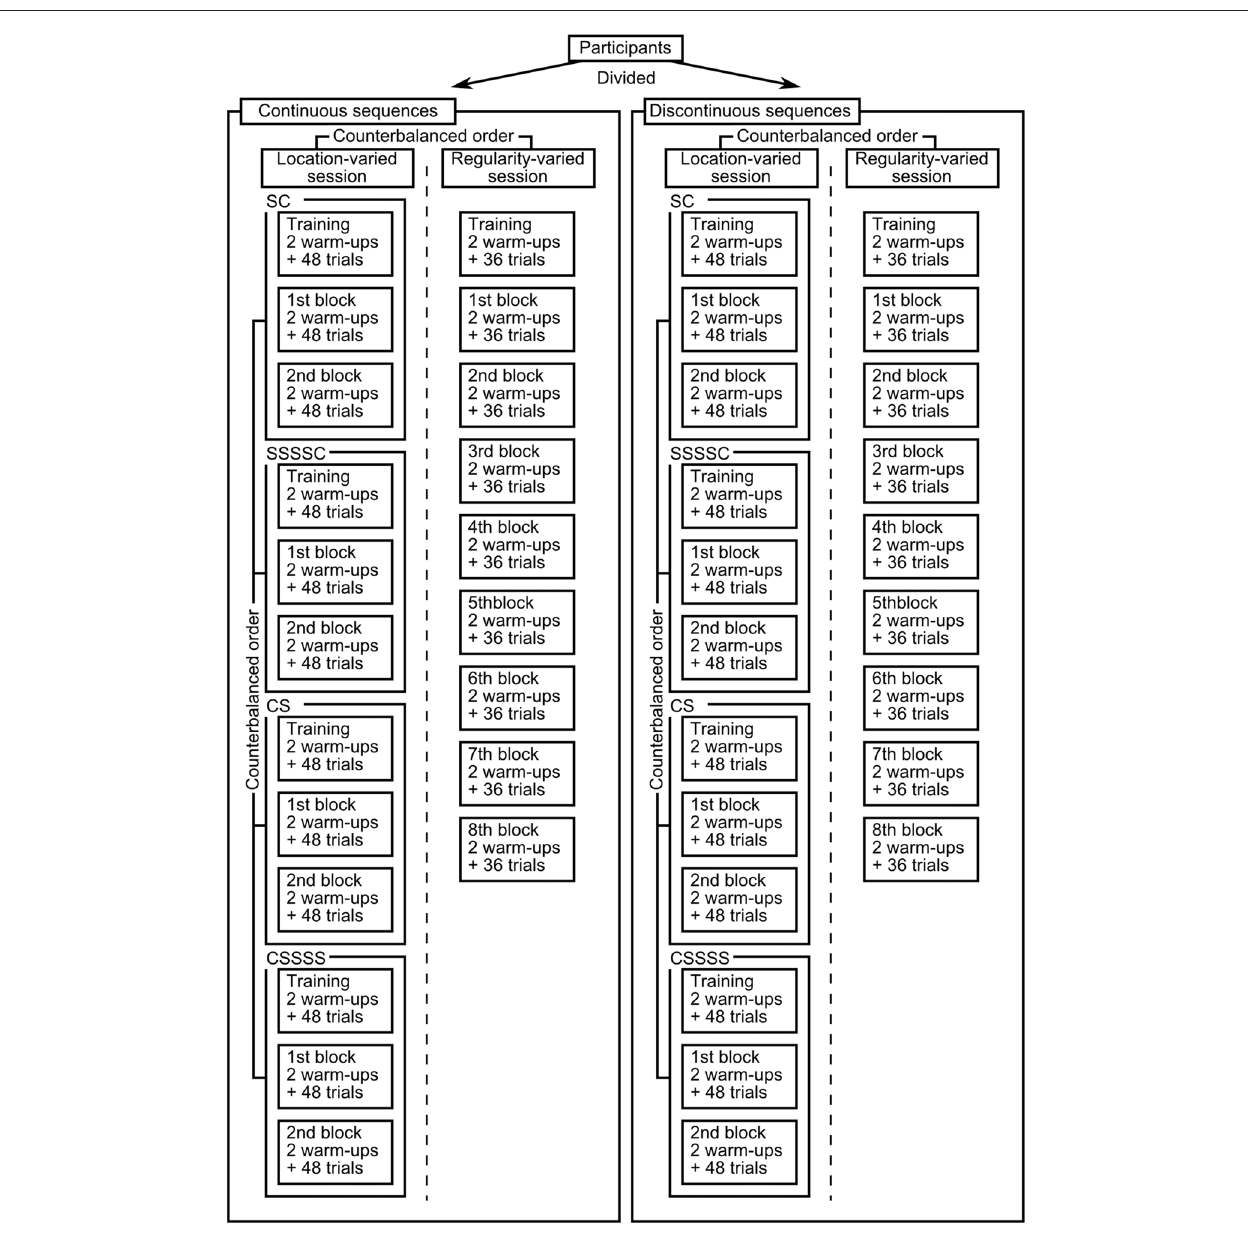
FIGURE 2 | Experimental